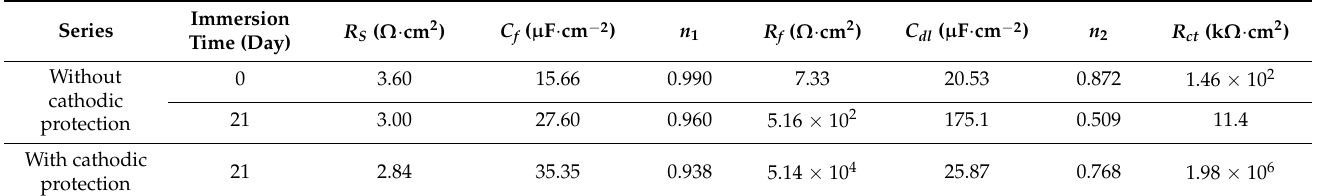
without and with cathodic